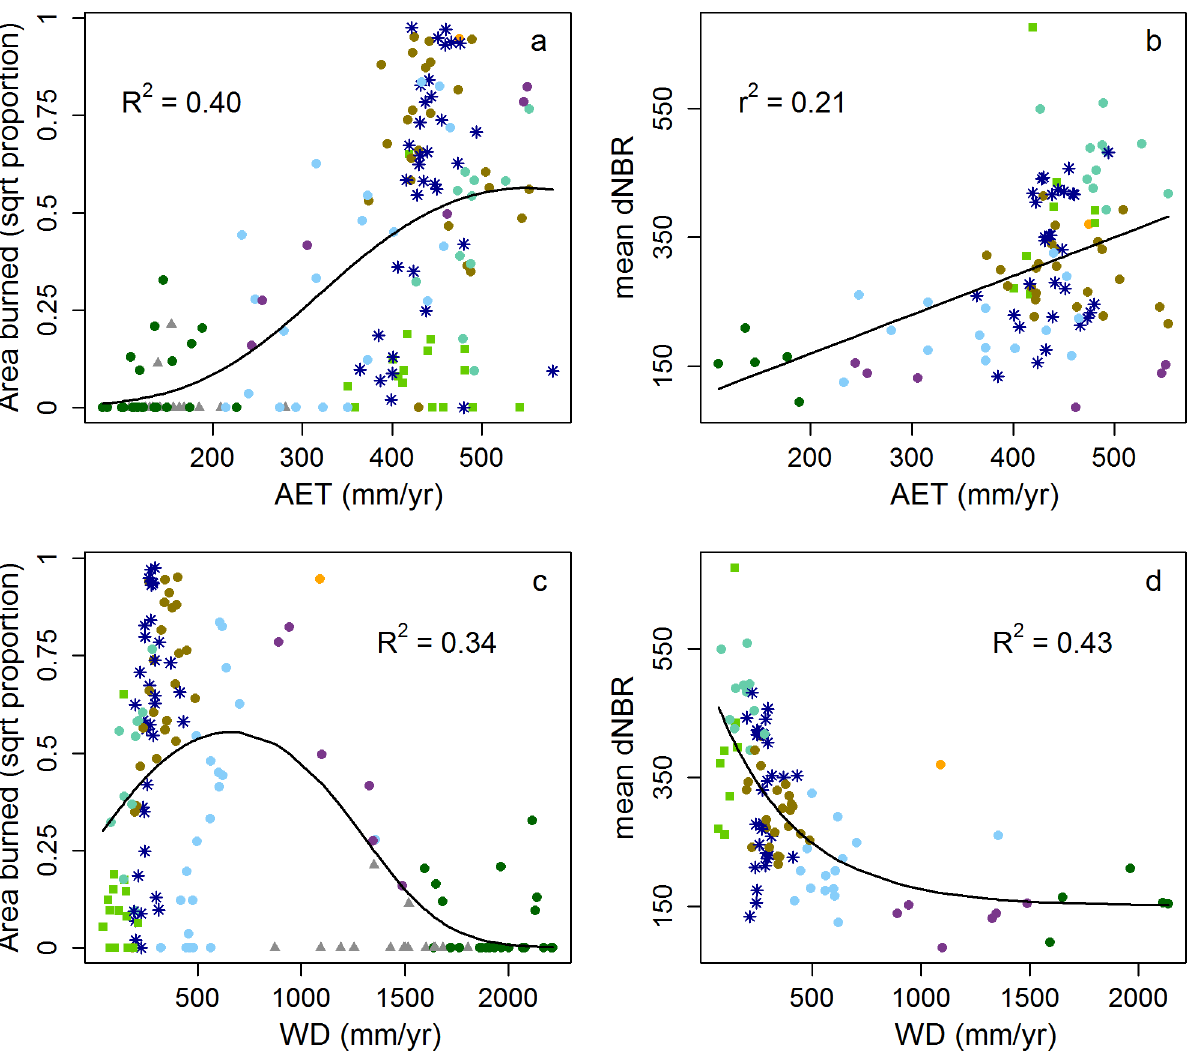
Figure 2. Area burned plotted against AET (a) and WD (b). Mean dNBR plotted against AET (c) and WD (d). Fitted lines are generated by models of each relationship (see Methods); the strength of each model is reported (R 2 or r 2 ). Symbol colors correspond to the ecoregion in which it is located (Fig. 1).